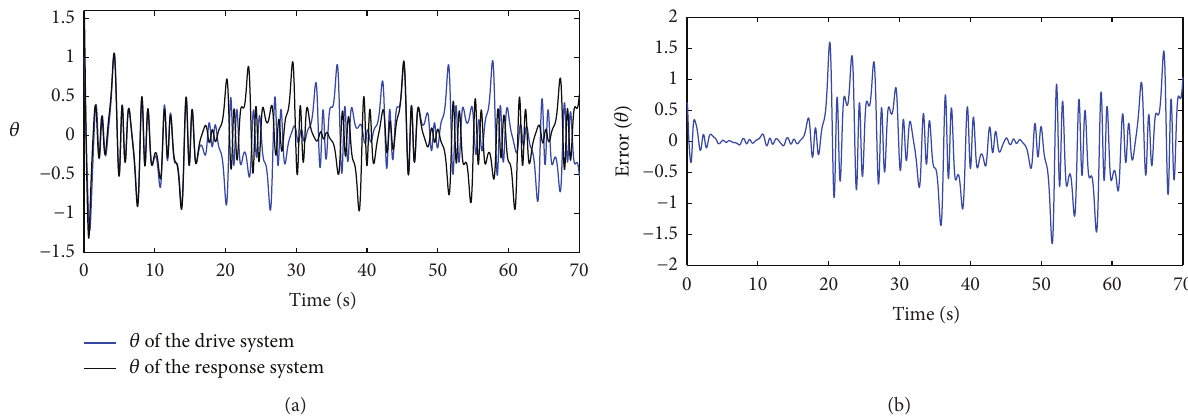
Figure 7: Simulation results of 𝜃 and error trajectories of unsynchronized chaotic gyros: (a) trajectories of 𝜃 of drive and response systems, (b) error behavior of 𝜃 .